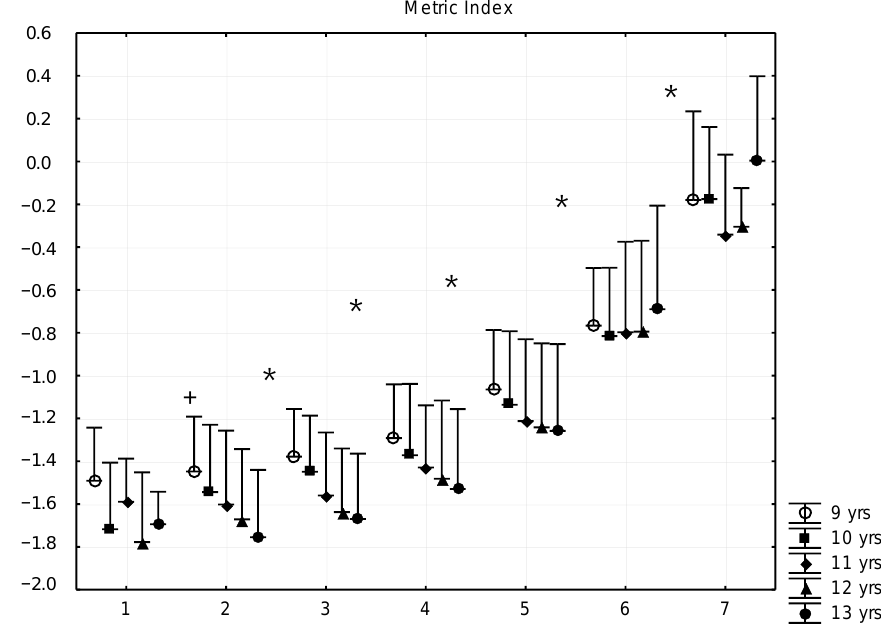
Figure 4. Relationship between body fat percentage and Conrad’s growth type metric index (mean + SD). 1—F% < 8.00; 2—F% = 8–11.99; 3—F% = 12.00–15.99; 4—F% = 16.00–19.99; 5—F% = 20.00–23.99; 6—F% = 24.00–27.99; 7—F% > 28; F% body fat percentage; * significant difference among subsequent groups, + significant difference in certain consecutive groups, p < 0.05.